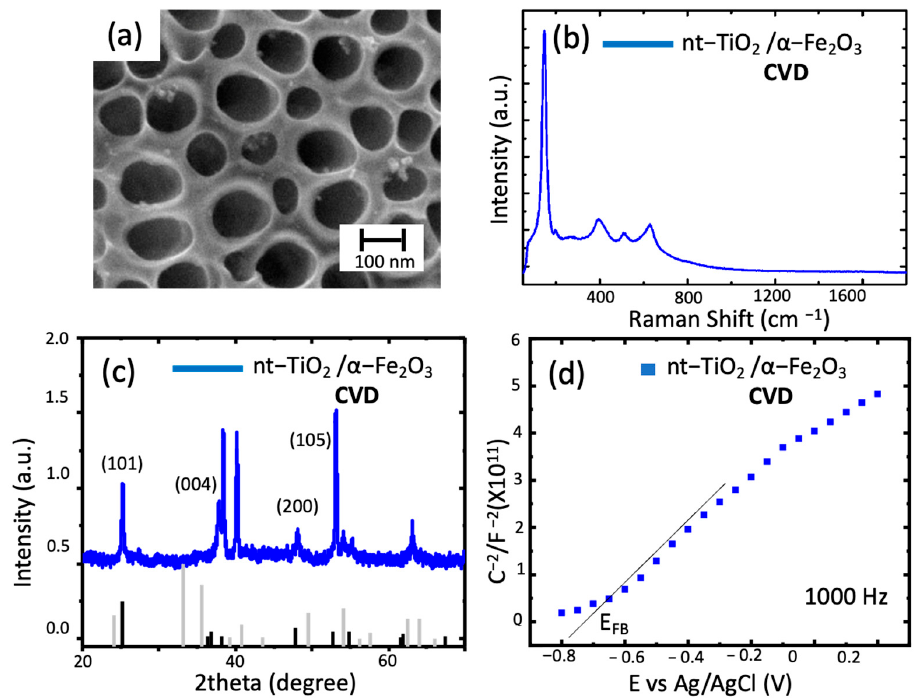
Figure 3. Characterizations of nt − TiO 2 / α − Fe 2 O 3 . ( a ) SEM micrographs of the top view of the TiO 2 nanotubes modified with hematite through CVD; ( b ) Raman spectra nt-TiO 2 / α -Fe 2 O 3 obtained; ( c ) diffraction spectra of the nanotubes (black lines correspond to TiO 2 , gray lines correspond to hematite); ( d ) Mott–Schottky plot of the sample at 1000 Hz.